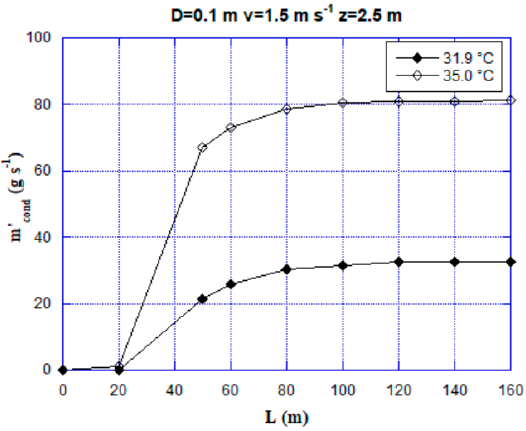
Figure 12. Amount of condensed water with length parameterized for inlet temperature of the air.